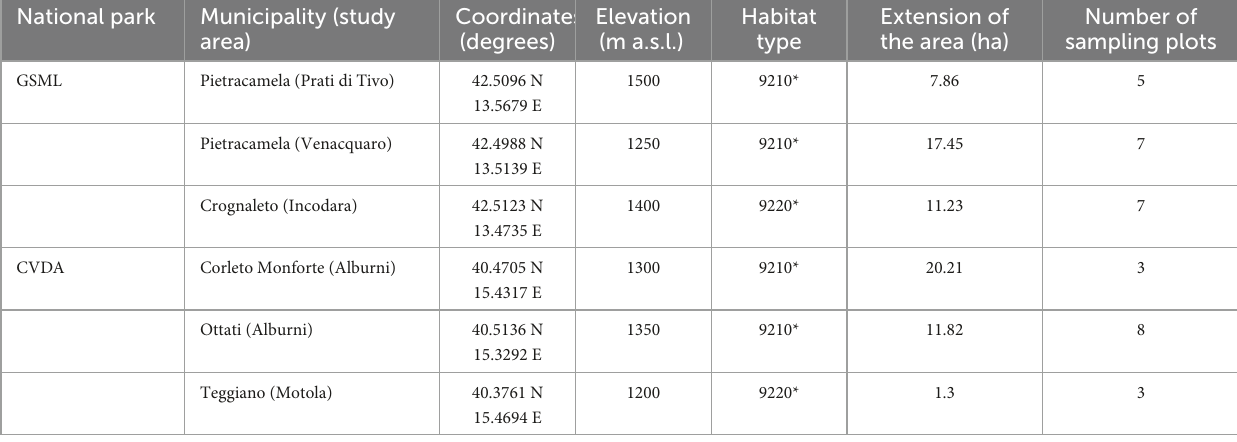
TABLE 1 Main characteristics of the study areas from Sabatini et al. (2016). National park Municipality (study